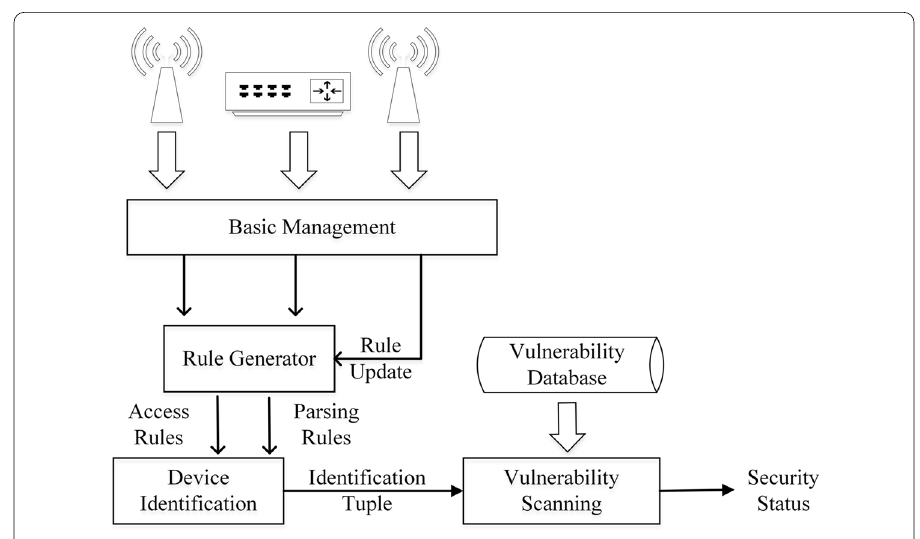
Fig. 2 The infrastructure of